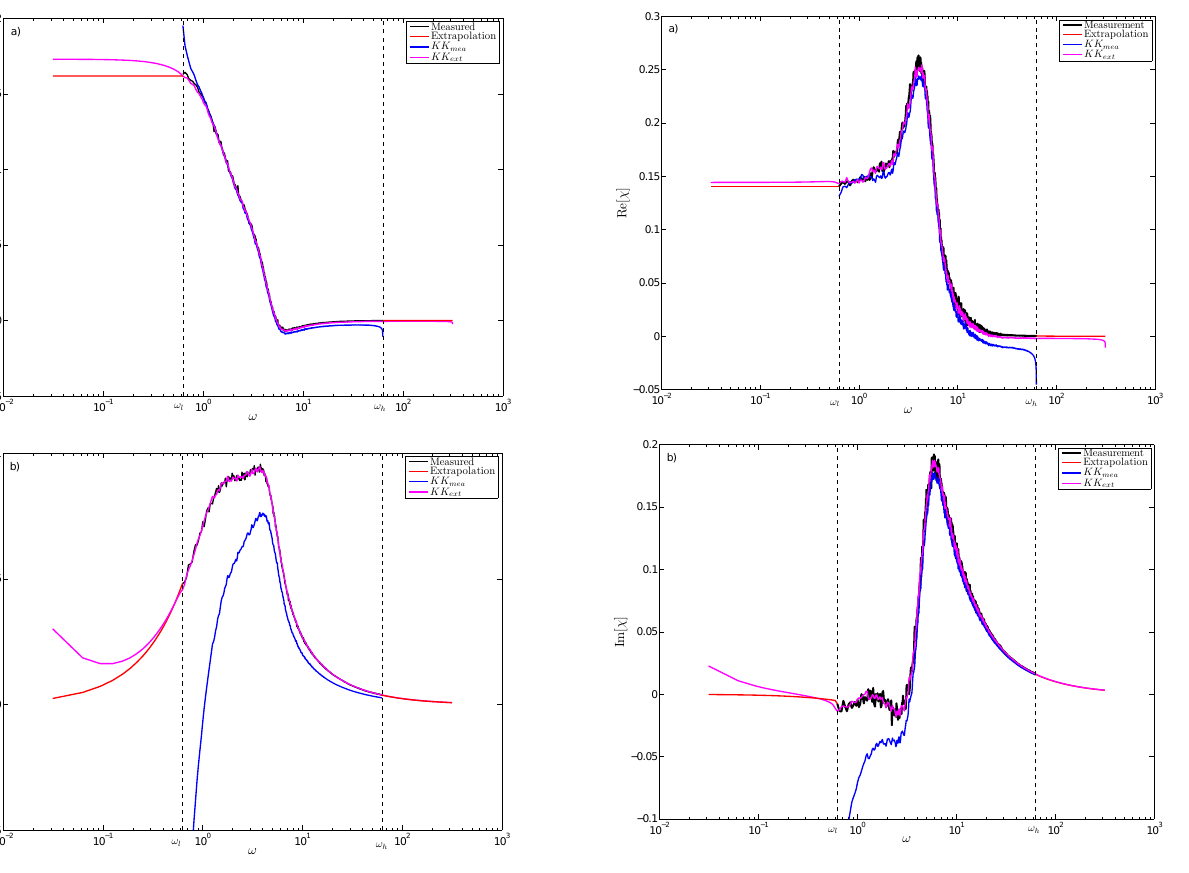
Fig. 1. Linear susceptibility of intensive energy of the system E/N with respect to the global perturbation with X i = 1 ∀ i . The real and the imaginary parts are depicted in (a) and (b) , respectively. The measured and extrapolated values are shown in red and black lines, respectively. The result of the Kramers-Kronig inversion done with the measured and with with the extrapolated data are shown in blue and magenta lines, respectively.